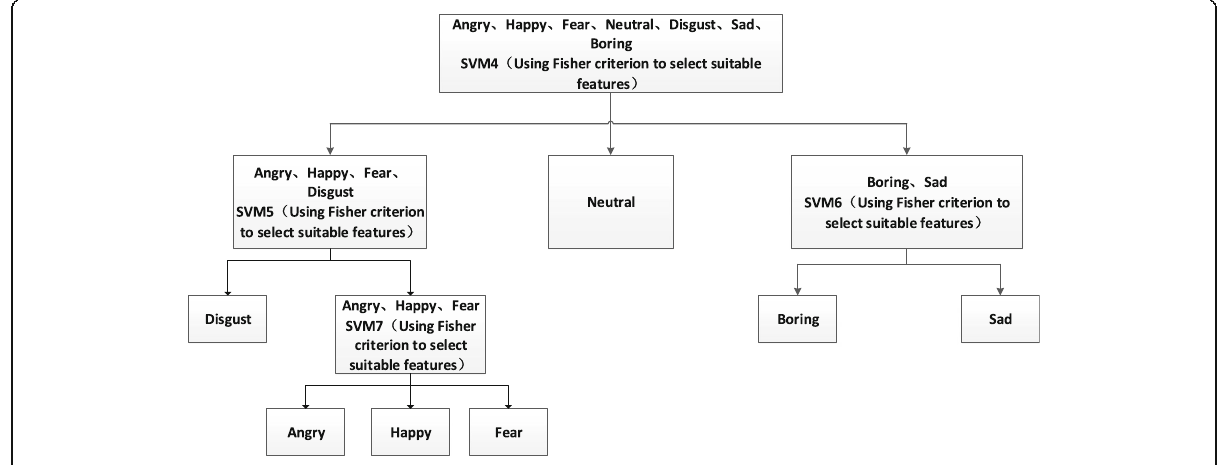
Fig. 6 System framework for